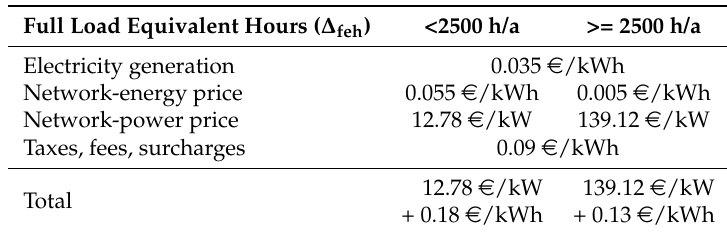
Table 1. Electricity price for exemplary industrial customer in Germany